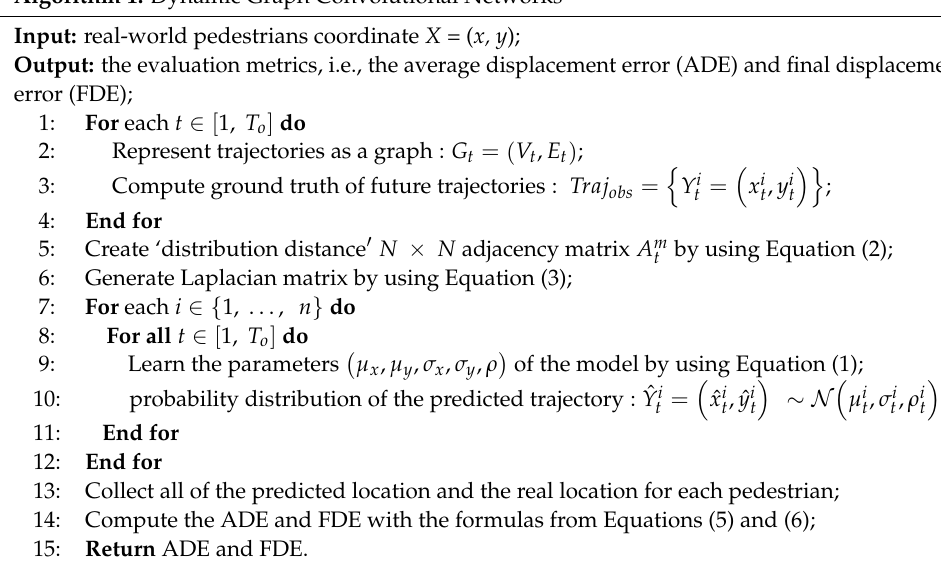
Algorithm 1. Dynamic Graph Convolutional